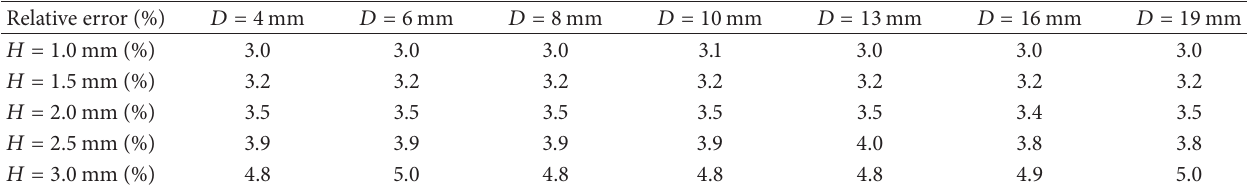
Table 1: Volume measurement error for cylinder cavity.